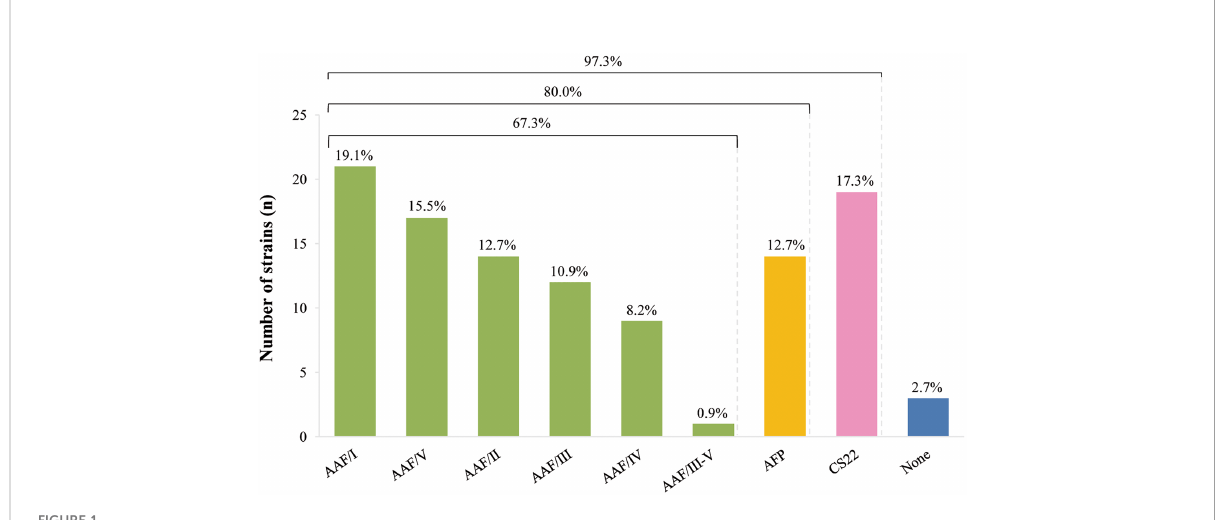
FIGURE 1 Distribution of AAF, AFP and CS22 related genes among 110 aatA + EAEC